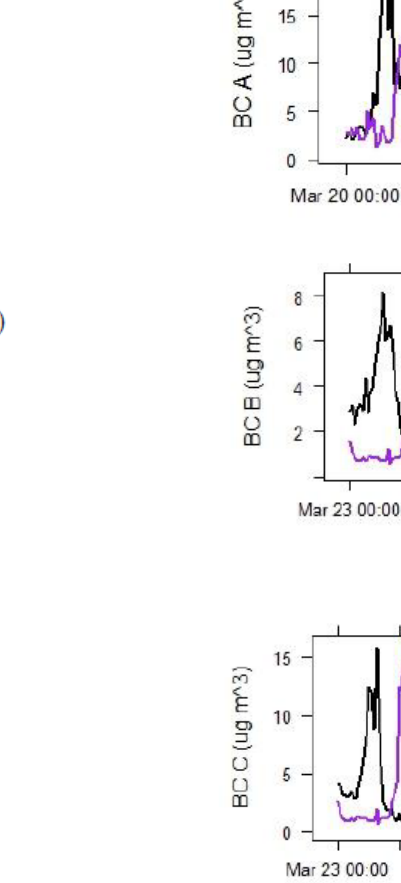
Figure 5. BC concentrations in dependence to normalized number of vehicles (NNV) in winter ( a ) and spring ( b ) time at measuring point A. BC concentrations peaked at morning and afternoon rush hours because of larger traffic density, which can be seen in Figure 5. In the evenings of the winter period, the BC concentrations increased further due to the heating of houses. In the spring, the evening increase in BC concentrations is smaller. Graphs for other measurement points also show a similar movement of BC concentrations as a function of NNV.